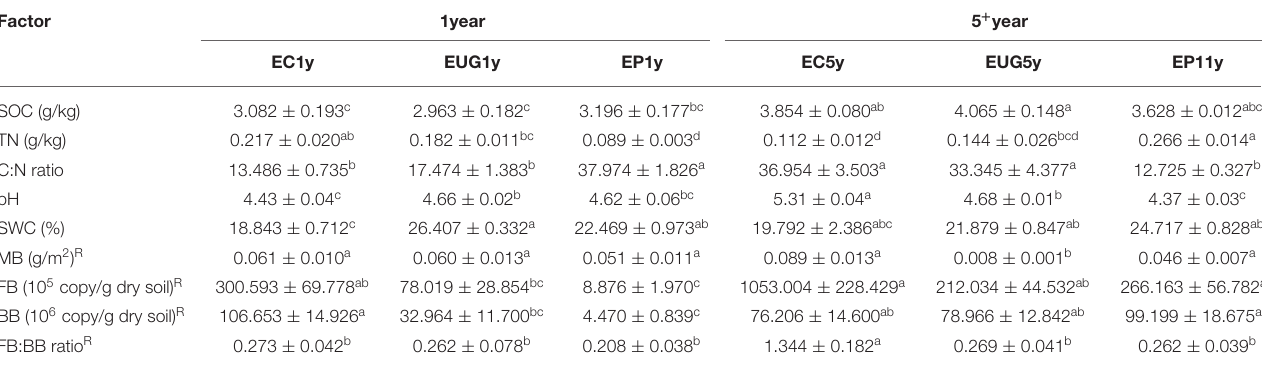
TABLE 1 | Soil physicochemical and microbial characteristics in Eucalyptus plantations.